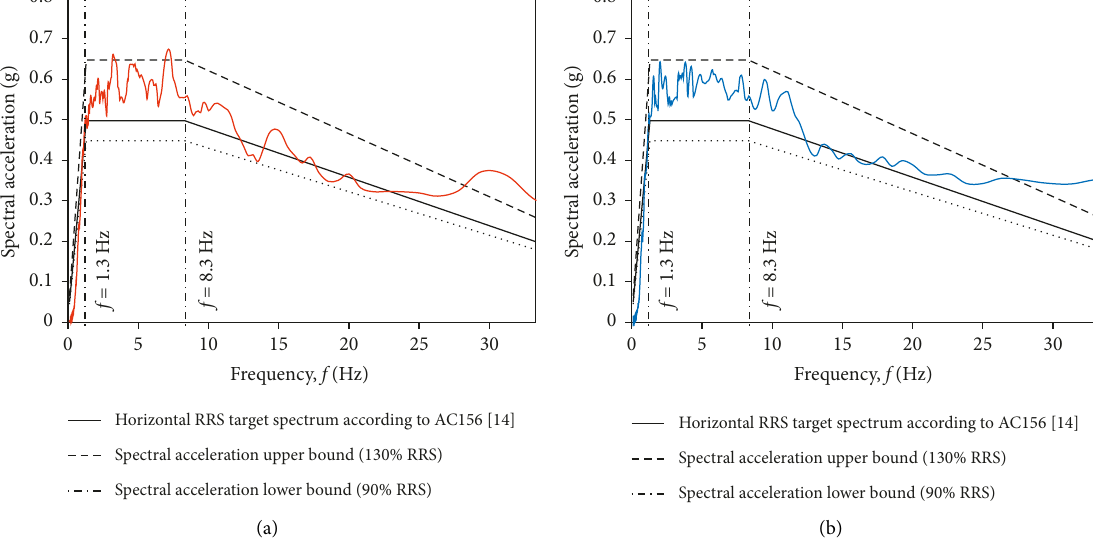
Figure 8: Input spectral acceleration (AC156_100) used in test specimen no. 5A versus the AC156 target spectrum with its limited boundaries. (a) X-direction. (b)